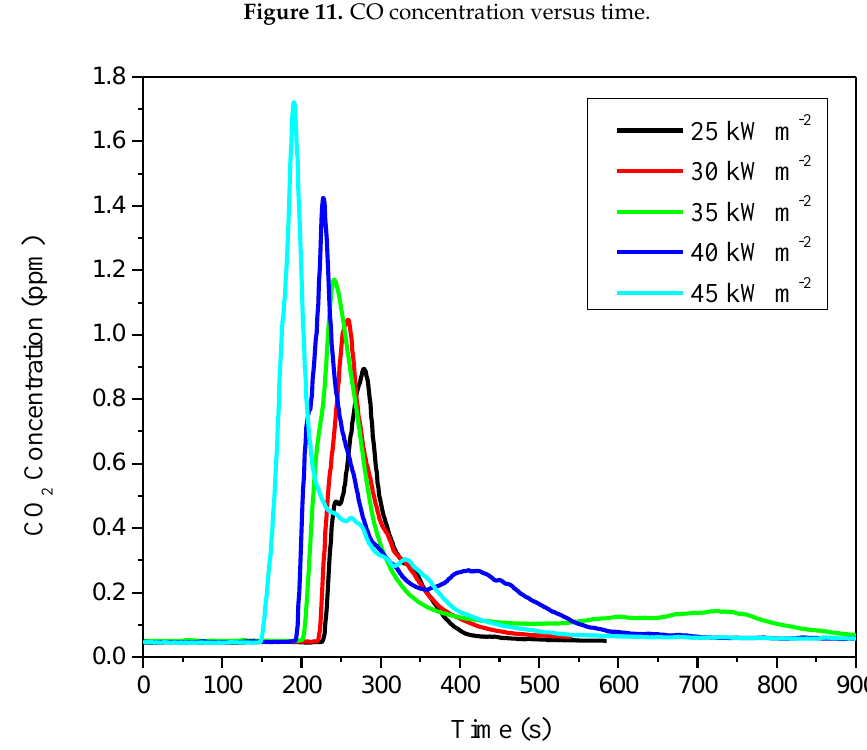
Figure 12. CO 2 concentration versus time.